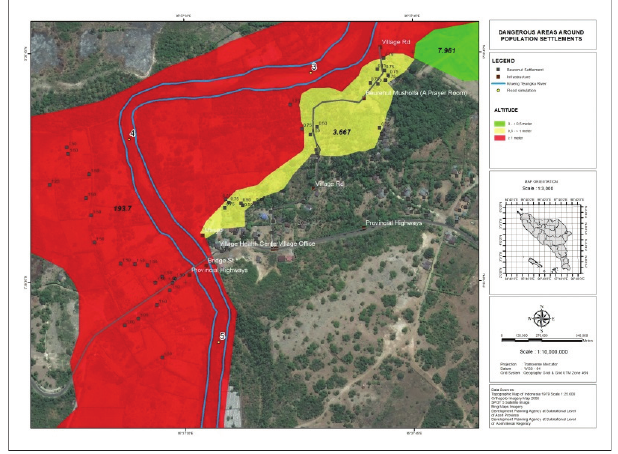
FIGURE 3: Dangerous areas around population settlements.